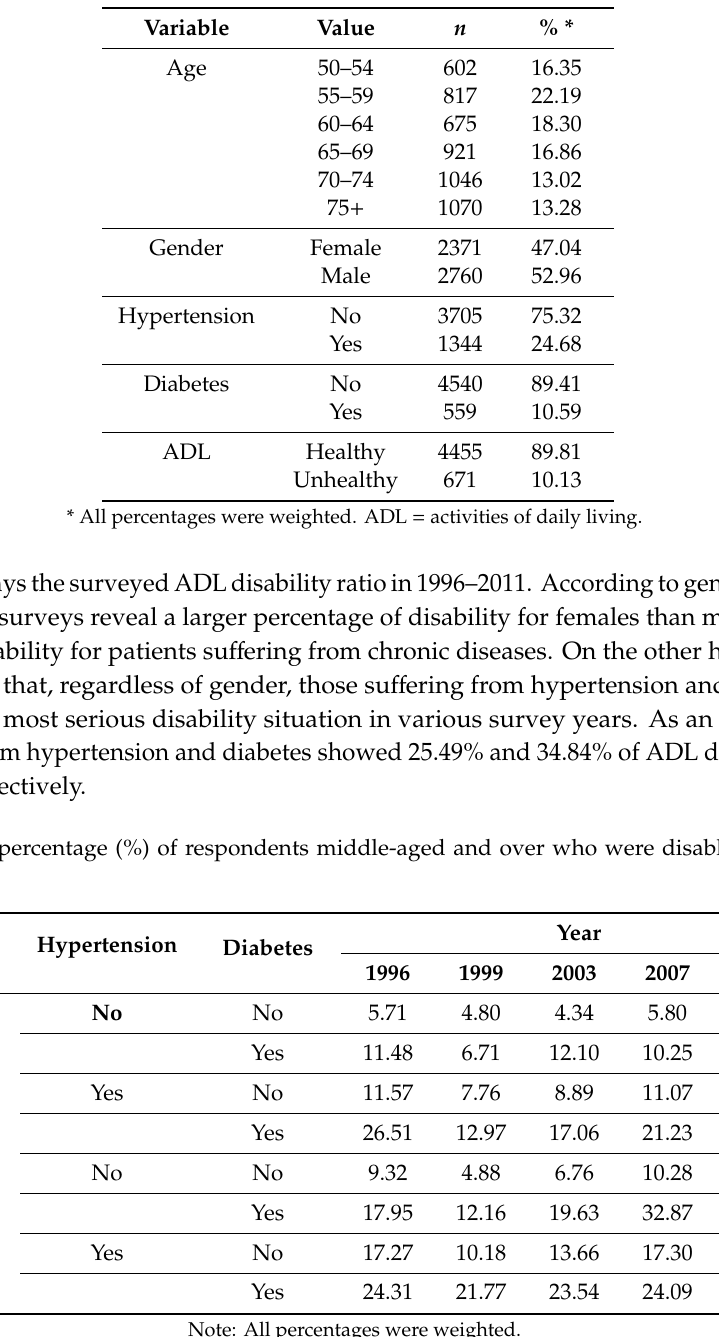
Table 1. Characteristics and status of respondents at interview in 1996 ( n = 5131).